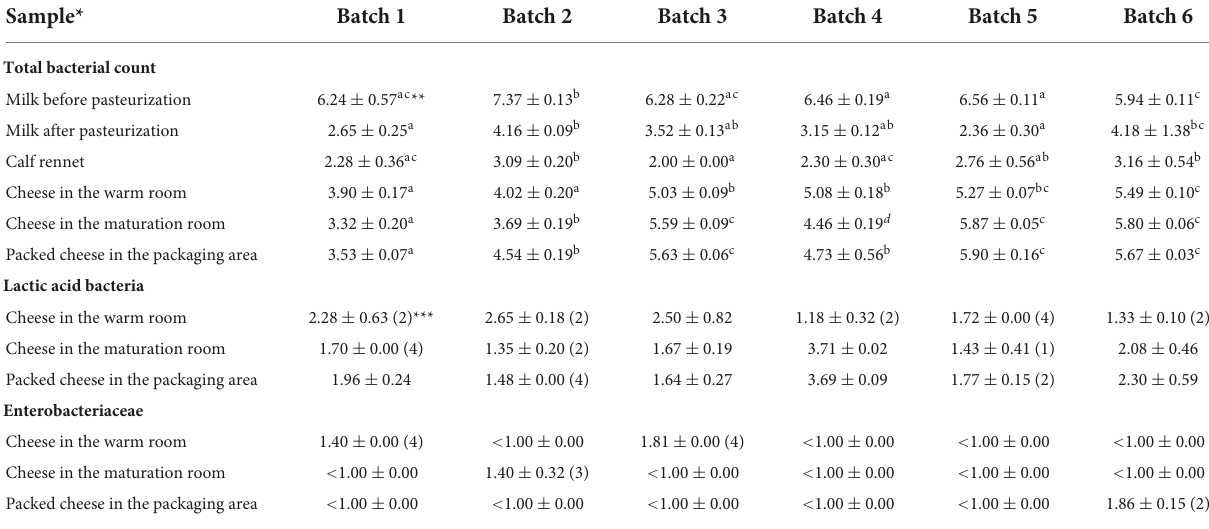
TABLE 1 Enumeration of total bacterial count, lactic acid bacteria, and Enterobacteriaceae in raw materials and cheese during processing. Sample*